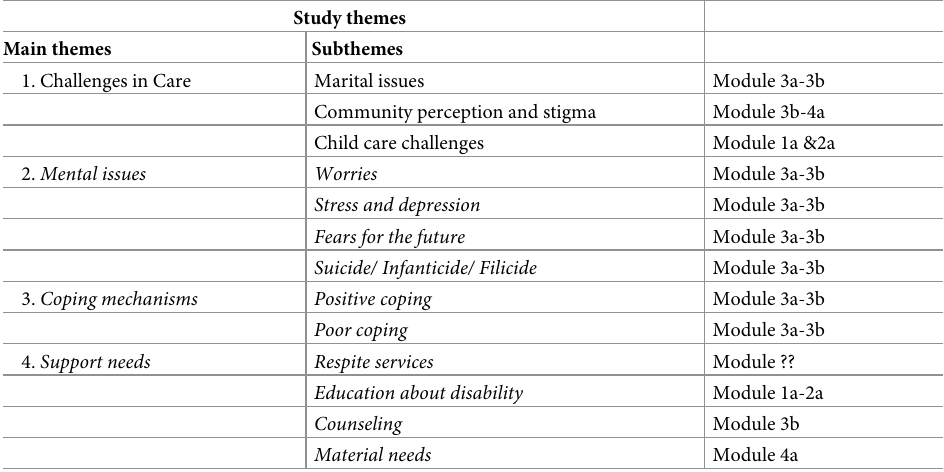
Table 3. Themes and corresponding modules of